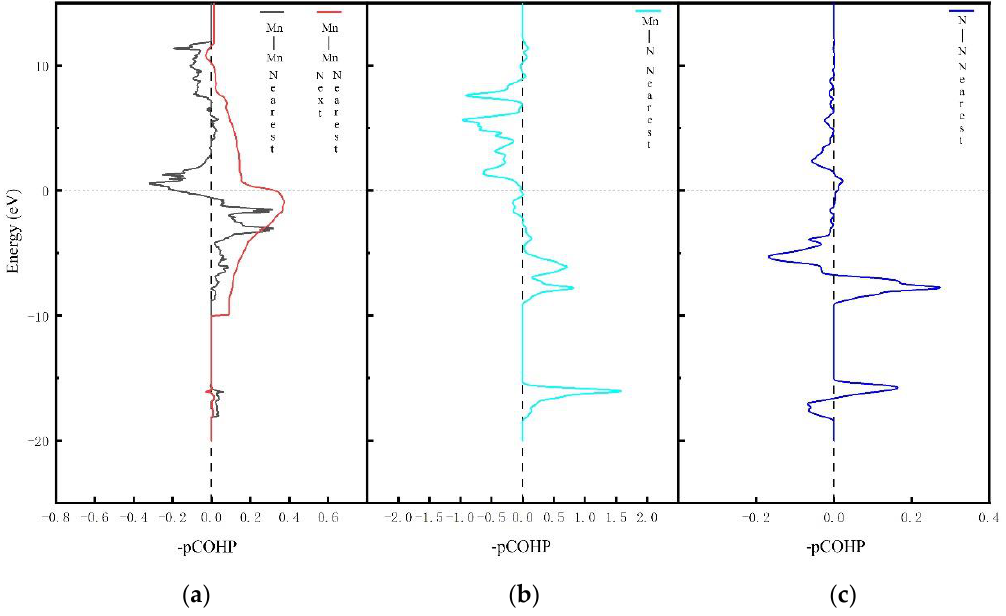
Figure 7. COHPs for Mn 3 N 2 . The negative and positive COHP values denote bonding and antibond- ing interactions, respectively. ( a ) shows the COHPs for Mn − Mn nearest and next nearest; ( b ) is the COHP for Mn − N nearest; ( c ) is the COHP for N − N nearest. Table 2. -ICOHP of bonds in Mn 3 N 2 .